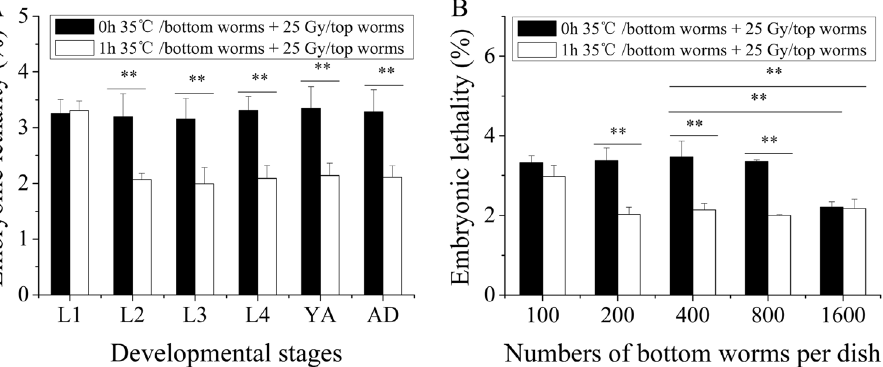
Figure 2. The production of the volatile stress signals in heat-stressed worms depends on their developmental stage and culture density. ( A ) Effect of developmental stage on the production of the volatile stress signals; ( B ) Effect of the culture density on the production of the volatile stress signals. Results are means ± SD (n = 5, ** P <